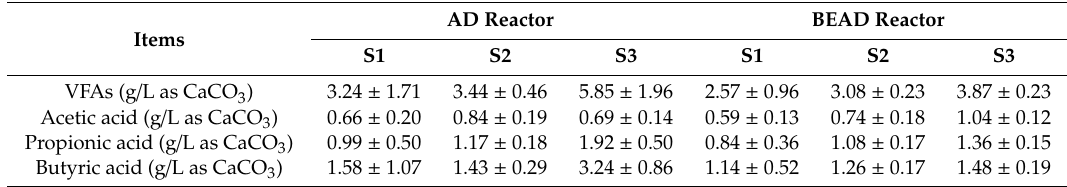
Table 3. VFAs (acetic acid, propionic acid, and butyric acid) concentrations in AD and BEAD reactors at each OLRs stage. AD: anaerobic digestion; BEAD: bio-electrochemical anaerobic digestion; VFAs: volatile fatty